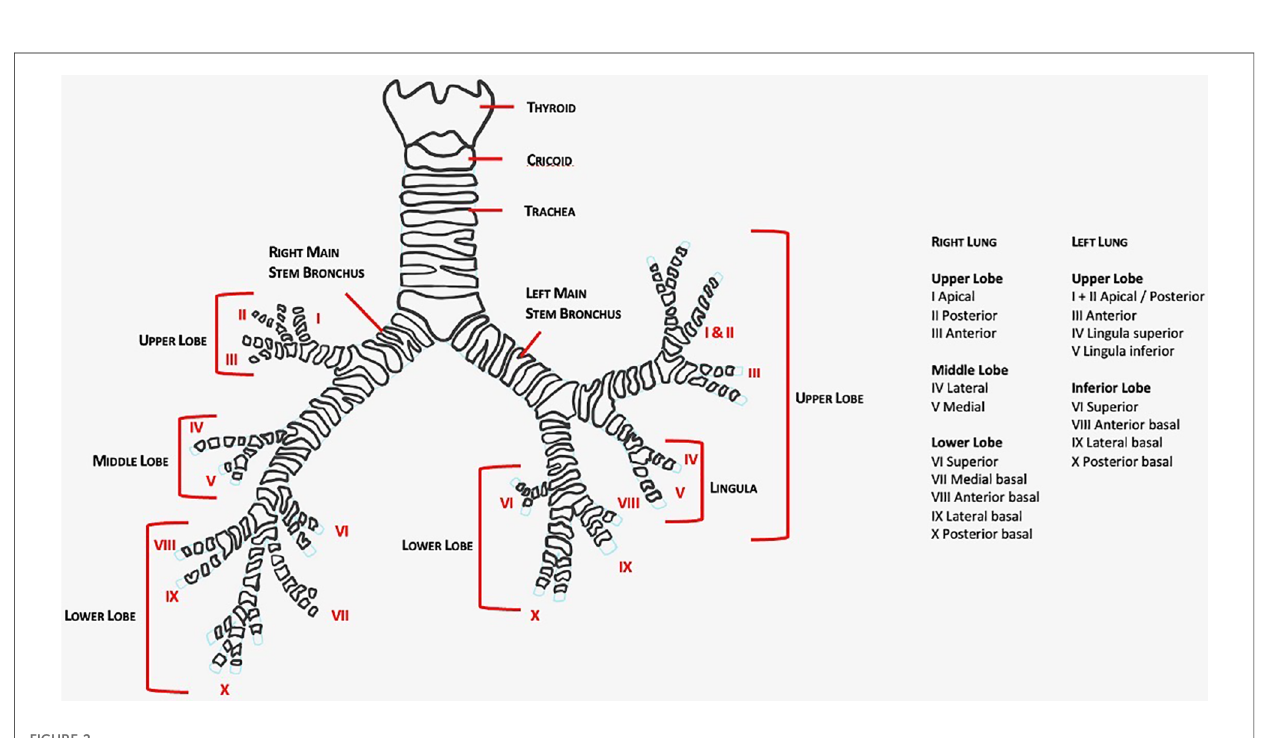
and 2 are placed posterior to port 3 and port 4 is placed anterior to port 3 all in the same intercostal space maintaining 6 cm – 10 cm between ports. The most posterior port, port 1, is placed